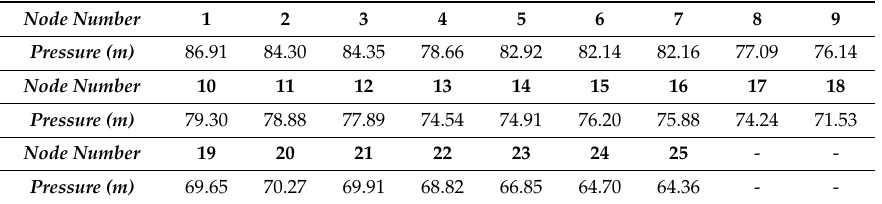
Table 1. Nodal pressures in the initial balance state.